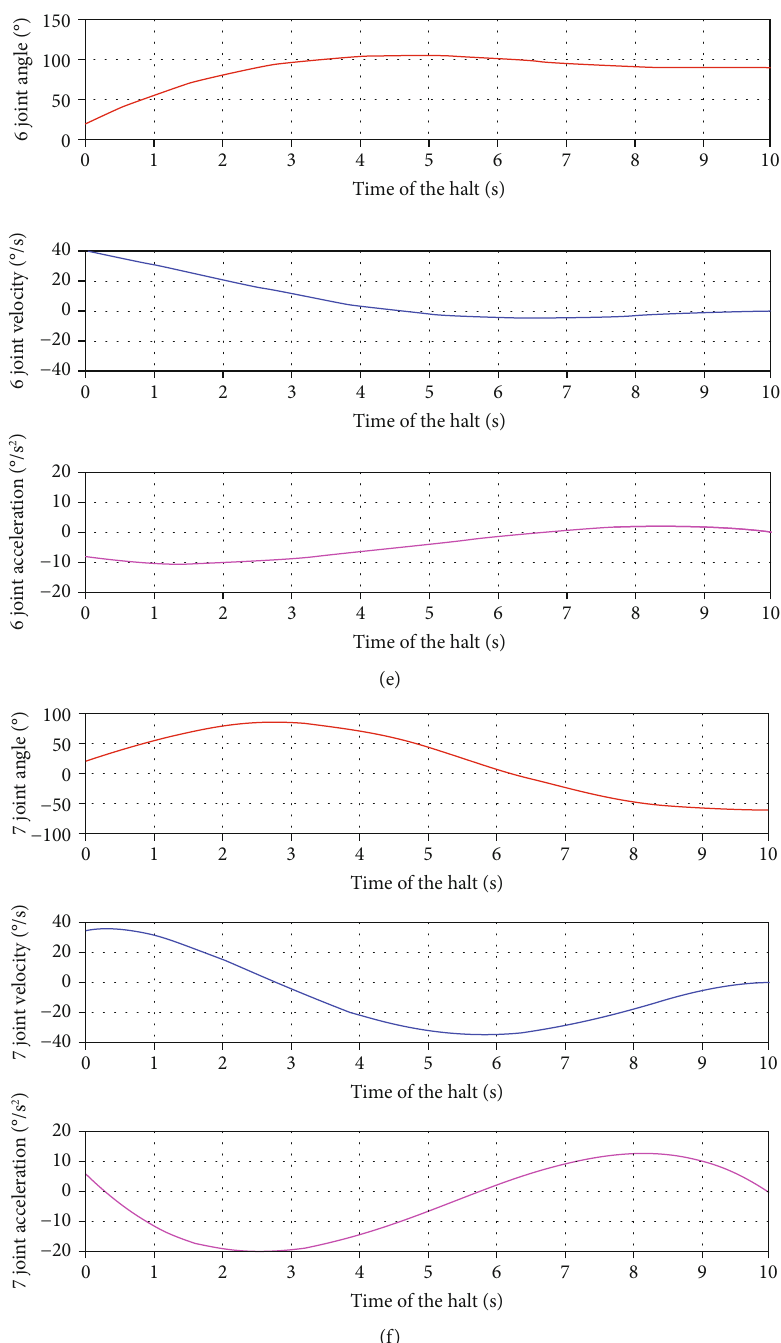
Figure 9: The variations of joint parameters. (a) The parameters of joint 1. (b) The parameters of joint 2. (c) The parameters of joint 3. (d) The parameters of joint 5. (e) The parameters of joint 6. (f) The parameters of joint